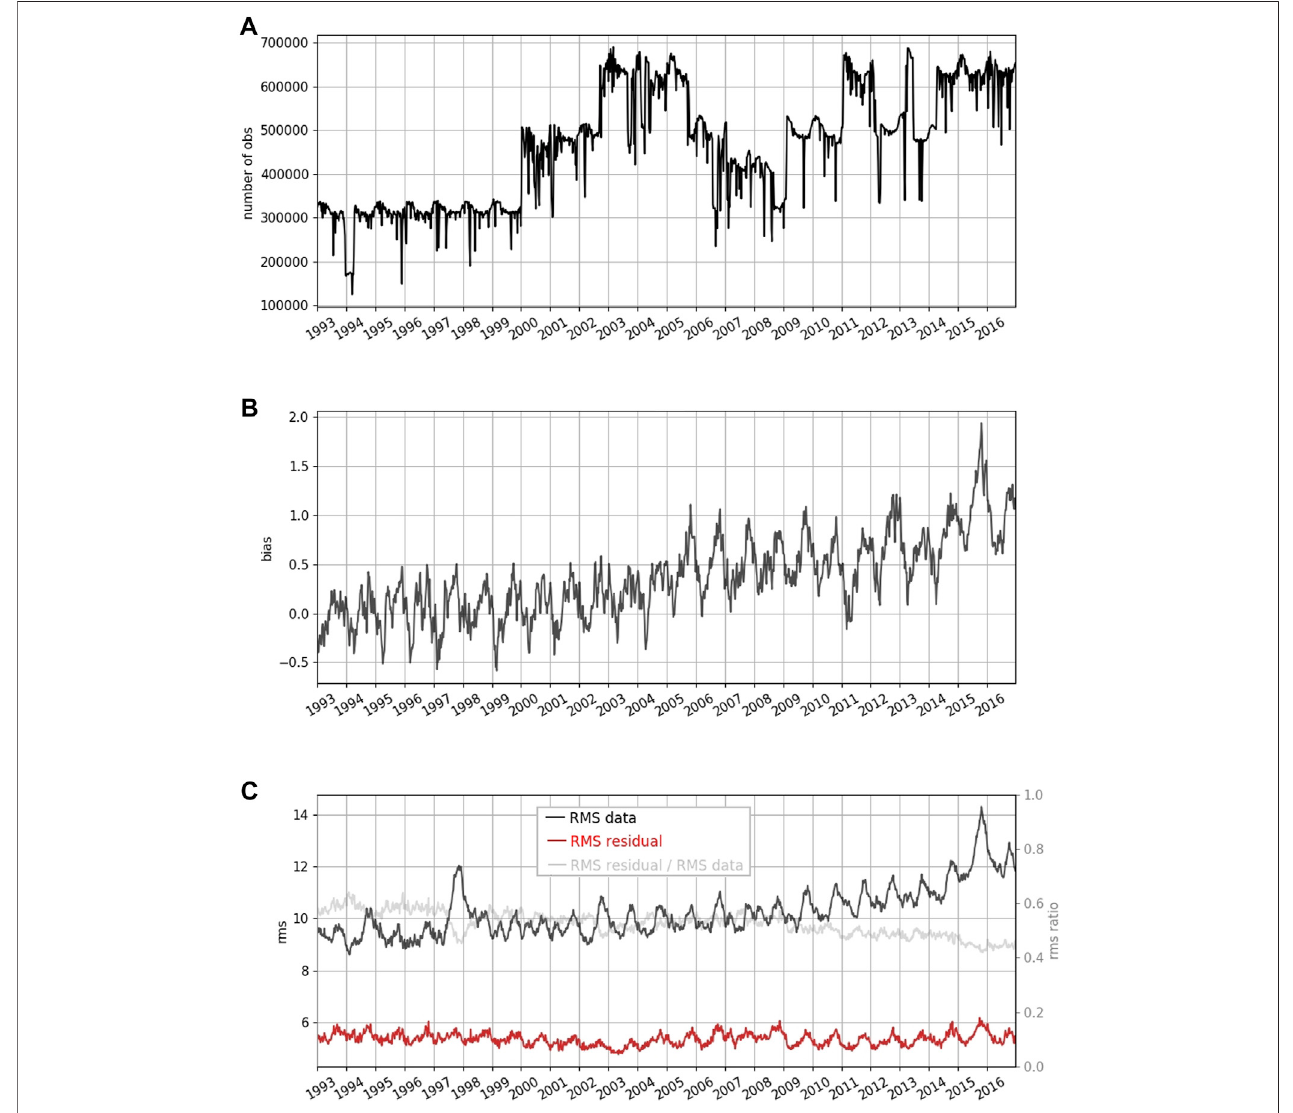
FIGURE3| TimeevolutionofSLAdataassimilationstatisticsaveragedoverthewholedomain: (A) datanumber, (B) meaninnovations, (C) RMSoftheSLAdata(in black), RMS of residuals (in red), RMS of residuals divided by RMS of SLA observations (in light grey, with the scale on the right). The scores are averaged over all seven days of the data assimilation window, with a lead time equal to 3.5 days. Units are cm.